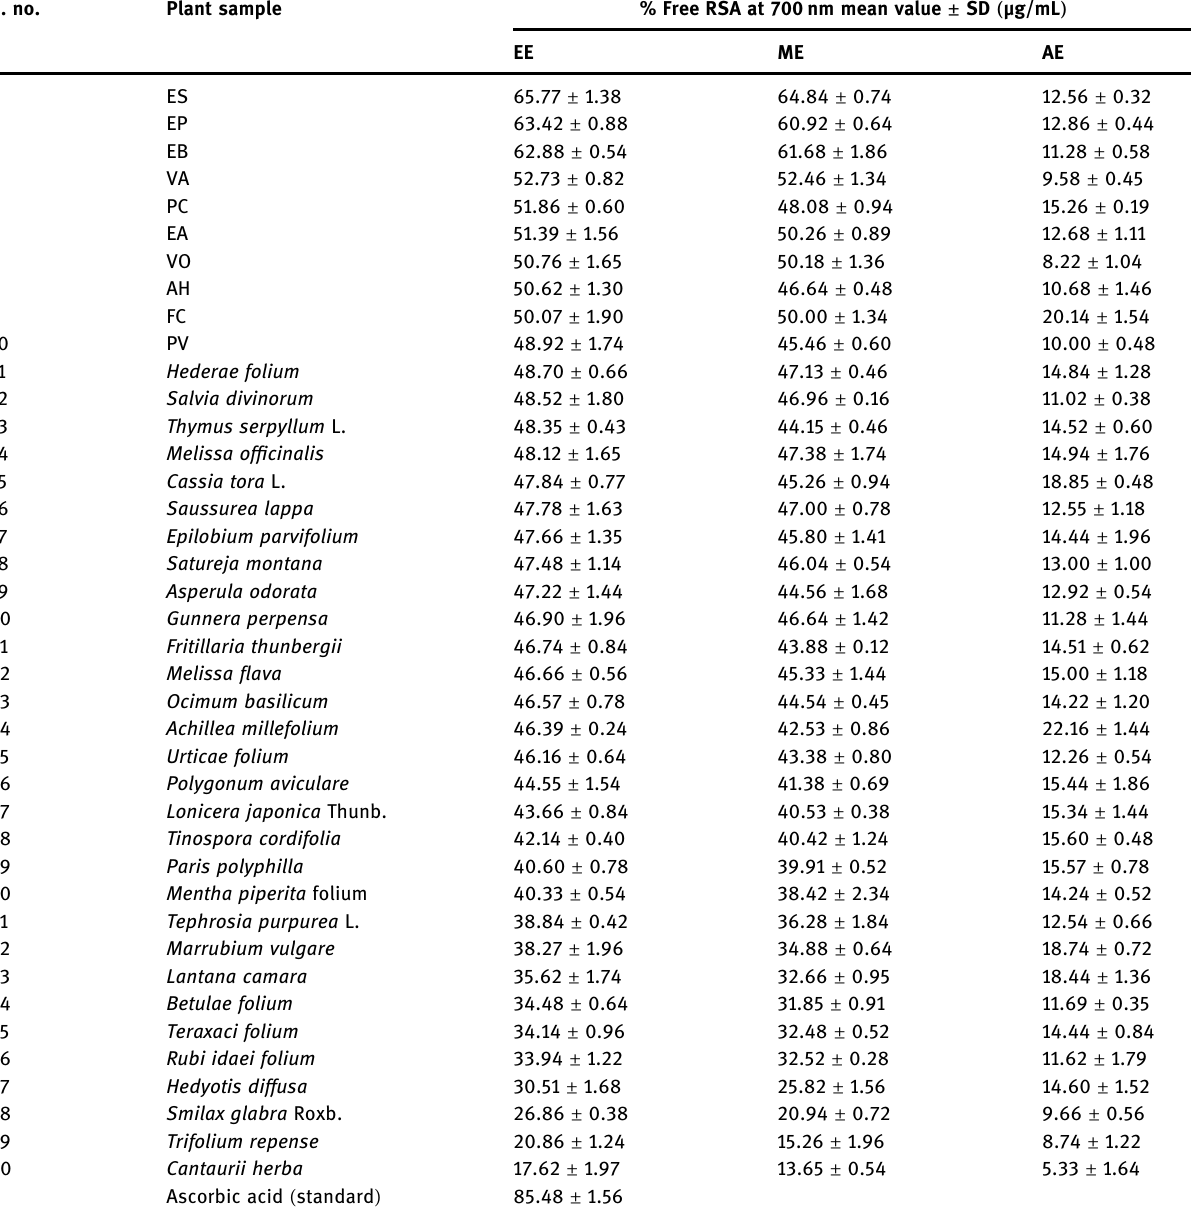
Table 6: The inhibitory e ff ects of various medicinal plant extracts in FRAP assay at 700 nm S. no. Plant